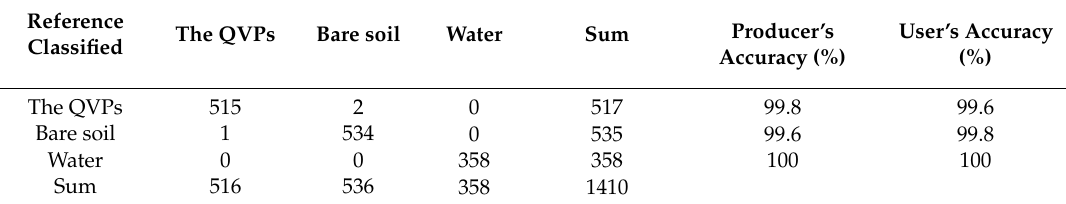
Figure 8. Overall classification accuracies and Kappa coefficients for land cover classification from the ten combined three-season datasets. Table 7. Confusion matrix showing the producer’s and user’s classification accuracies for three land cover classes obtained from the selected predictive variable datasets of the combined March–July– December images.